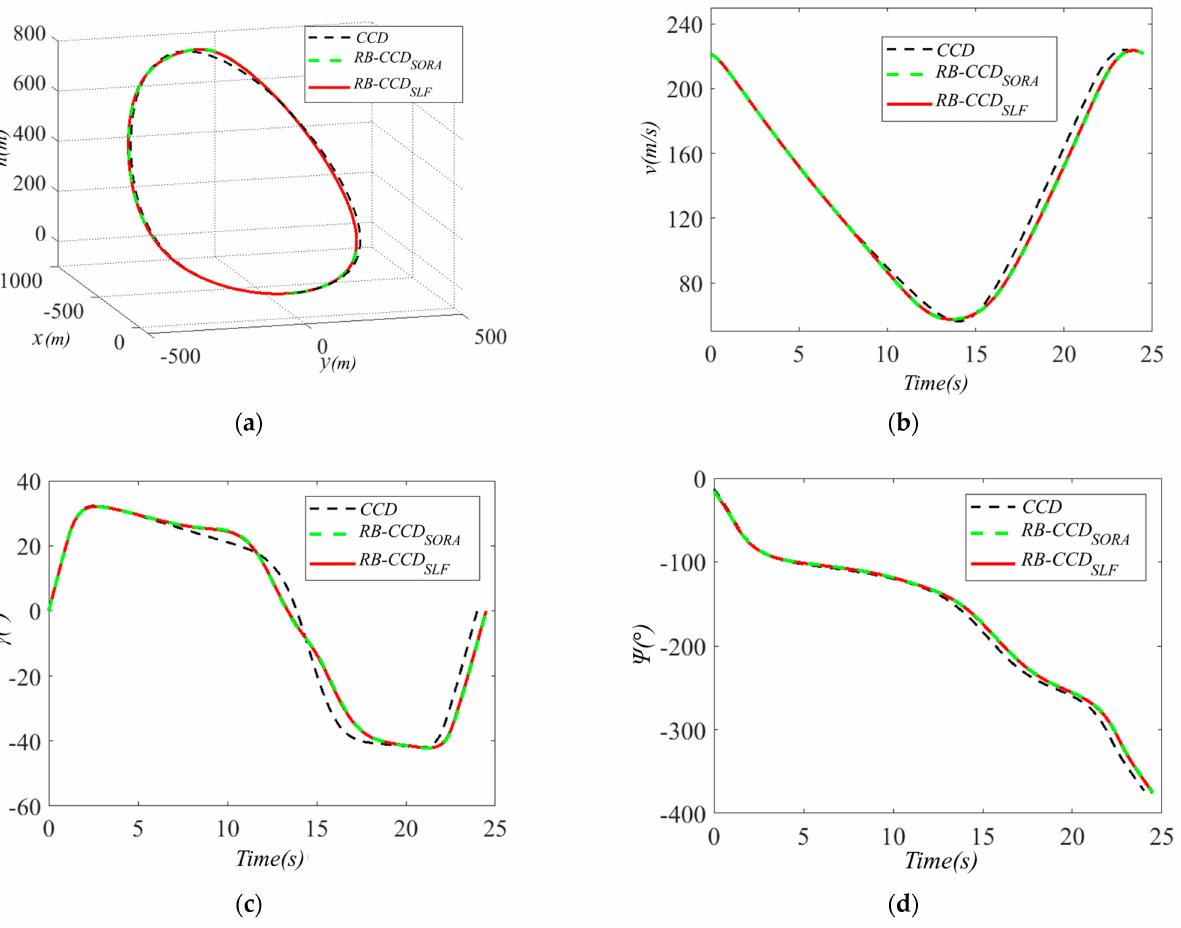
Figure 9. The optimal state trajectories in RB-CCD optimized by SORA and SLF: ( a ) x , y , h , ( b ) v , ( c ) γ , ( d ) Ψ